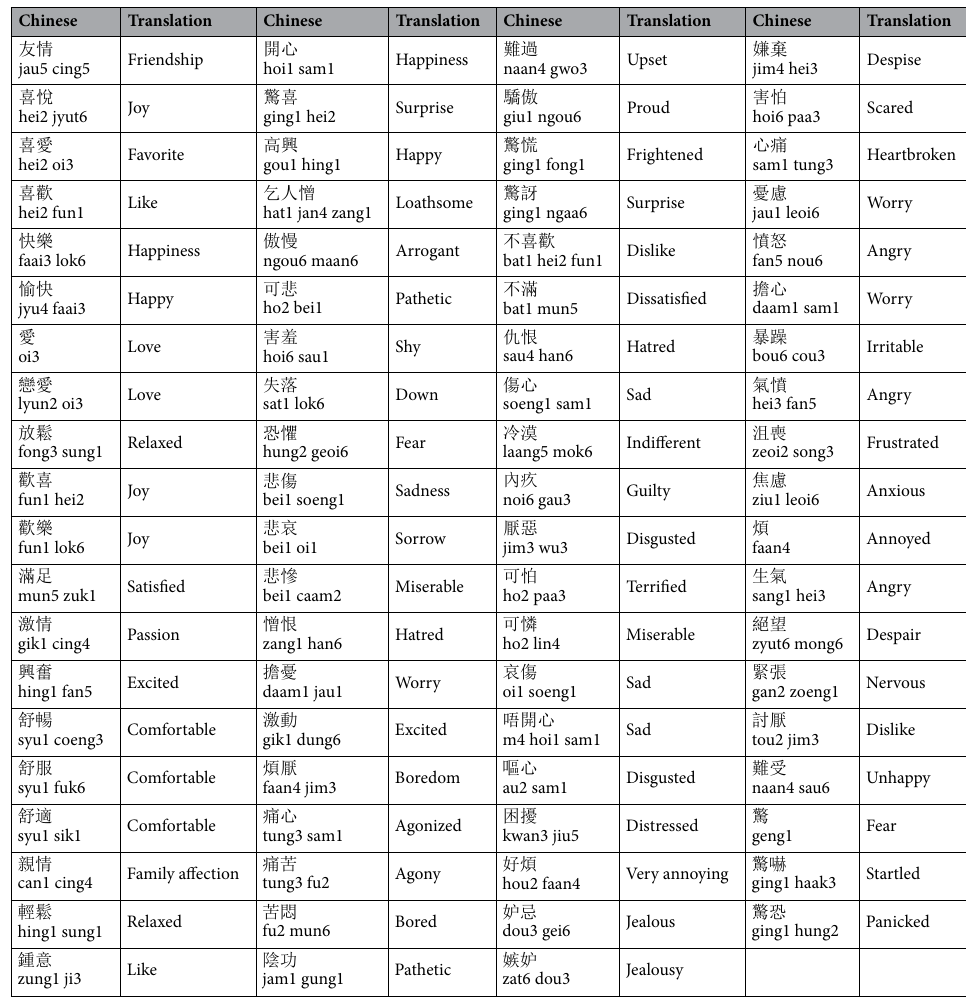
Table 1. Chinese and translation of 79 Cantonese emotion